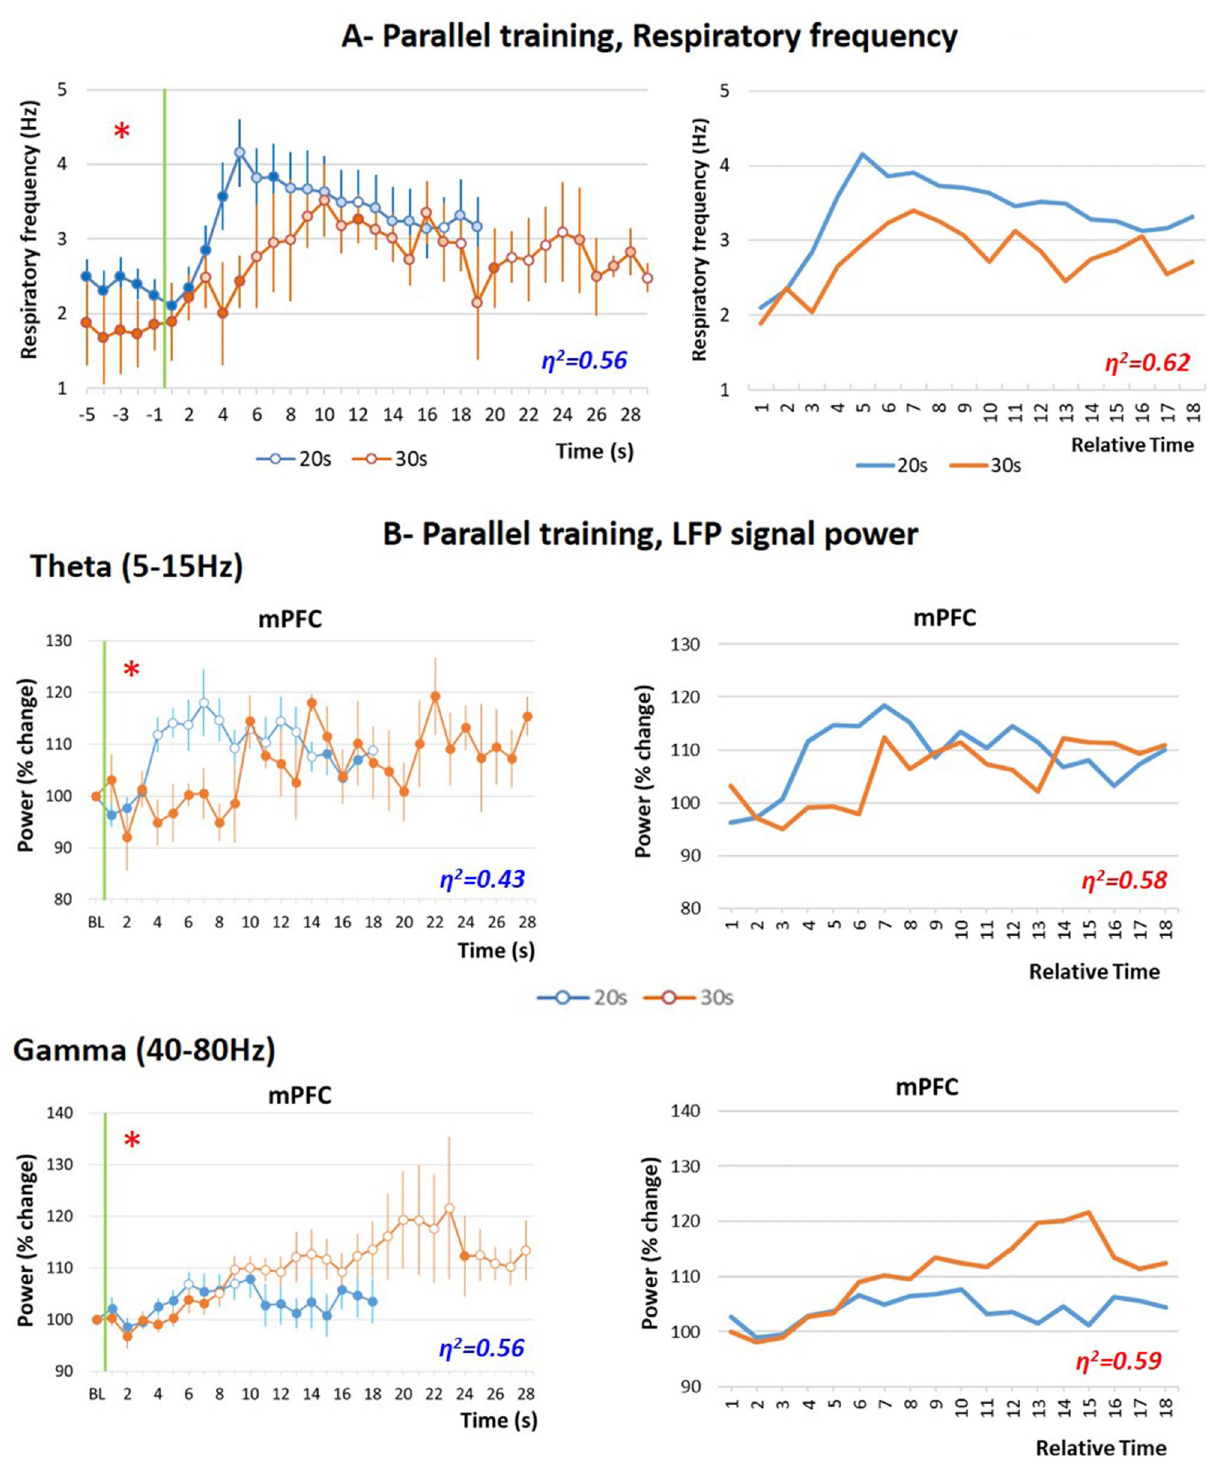
Figure 8. Behavioral and electrophysiological comparison in parallel training condition. ( A ) Respiratory frequency curves. Left side, raw data: the temporal pattern of respiratory frequency is represented with a 1-s bin precision, from 5 s before odor onset (green vertical line) to shock arrival which occurs either at 20 s (Group 20 s, in blue) or at 30 s (Group 30 s, in orange). Right side, rescaled curves: the time axis for the 30-s data (in orange) was multiplicatively rescaled. Superposition between the two curves was indexed by eta-square (η 2 ) indicated in the bottom right of each graph, the highest values being highlighted in red. ( B ) Local field potential (LFP) signal power in the mPFC (medial prefrontal cortex), in the theta (5–15 Hz) and gamma (40–80 Hz) bands. Left side, raw data: theta and gamma power was expressed as percent change from the baseline (BL), and represented from odor onset (green vertical line) to shock arrival which occurs either at 20 s (Group 20 s, in blue) or at 30 s (Group 30 s, in orange). Right side, rescaled curves. The red asterisk in the upper left corner of a graph signals a significant time × interval duration interaction. Open circles on each curve signal the values that are significantly different from the baseline (p < 0.05). Superposition between the two curves was indexed by eta-square (η 2 ) indicated in the bottom right of each graph, the highest values being highlighted in